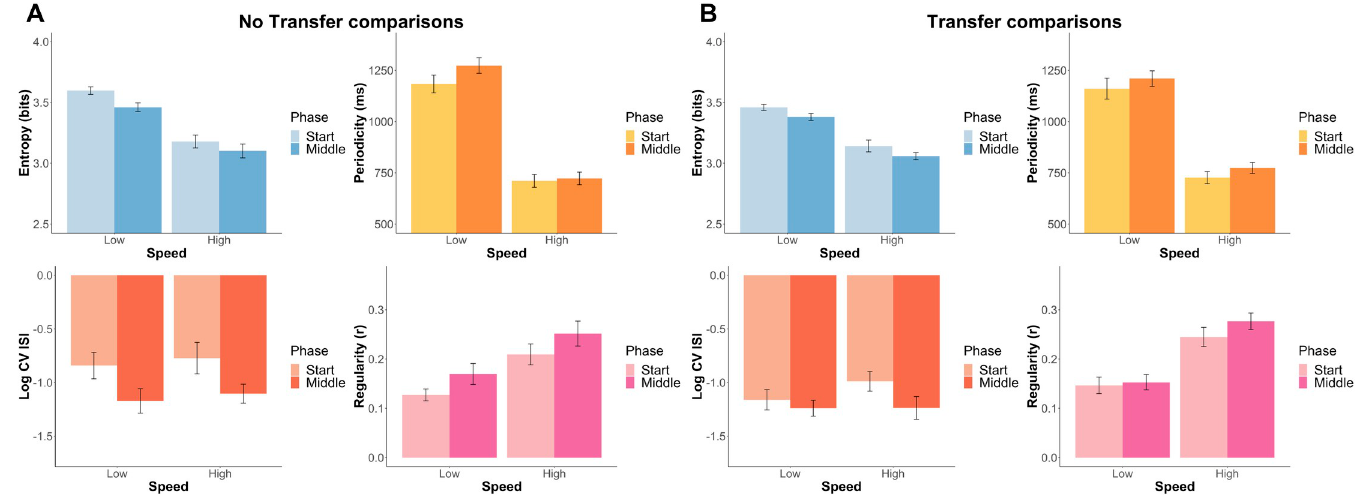
Fig 8. Comparison of human measures of motor learning across the Start phase (5 first games) and the Middle phase (5 middle games) of Auto Orbit . (A) No Transfer phase comparison of human entropy (blue), shot periodicity (yellow), shot timing variability (red), and shot regularity (pink) in the LLL (low speed only) and HHH (high speed only) conditions. (B) Transfer phase comparison of human entropy (blue), shot periodicity (yellow), shot timing variability (red), and shot regularity (pink) in the LHL (Low-Start & High-Middle) and HLH (High-Start & Low-Middle) conditions. The bar graph indicates means and standard errors of the means within speeds and phases.